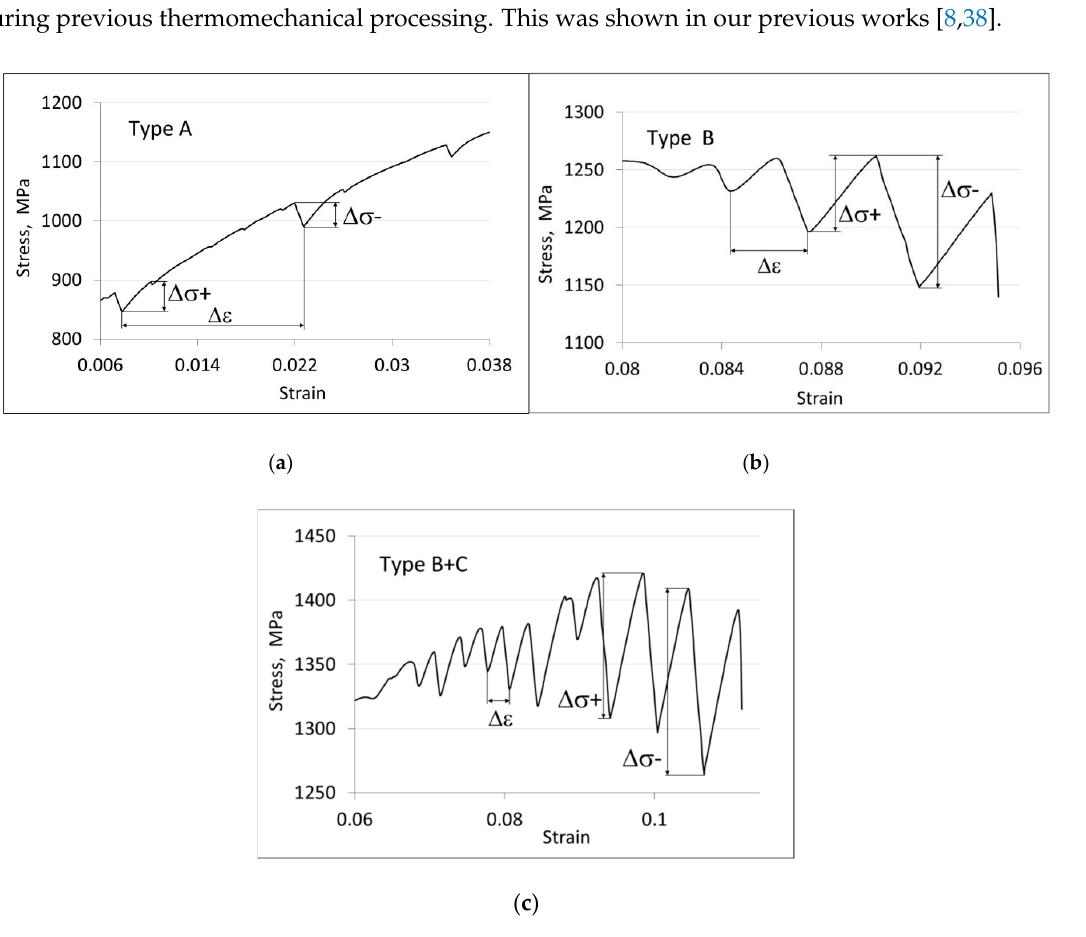
Figure 7. Details of serrations at the flow curves for the steel deformed at: 60 ° C ( a ), 100 ° C ( b ), and 140 ° C ( c ).